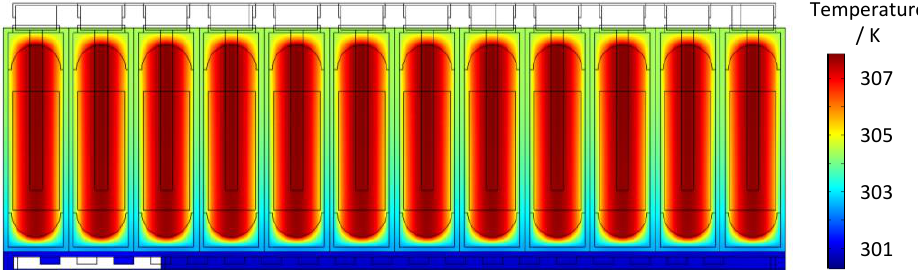
Figure A2. Temperature distribution for the middle cross-section of a battery module for a charging rate of 1 C. A slight temperature change cross the electrode appears. Heat transfer through the aluminum hard case.